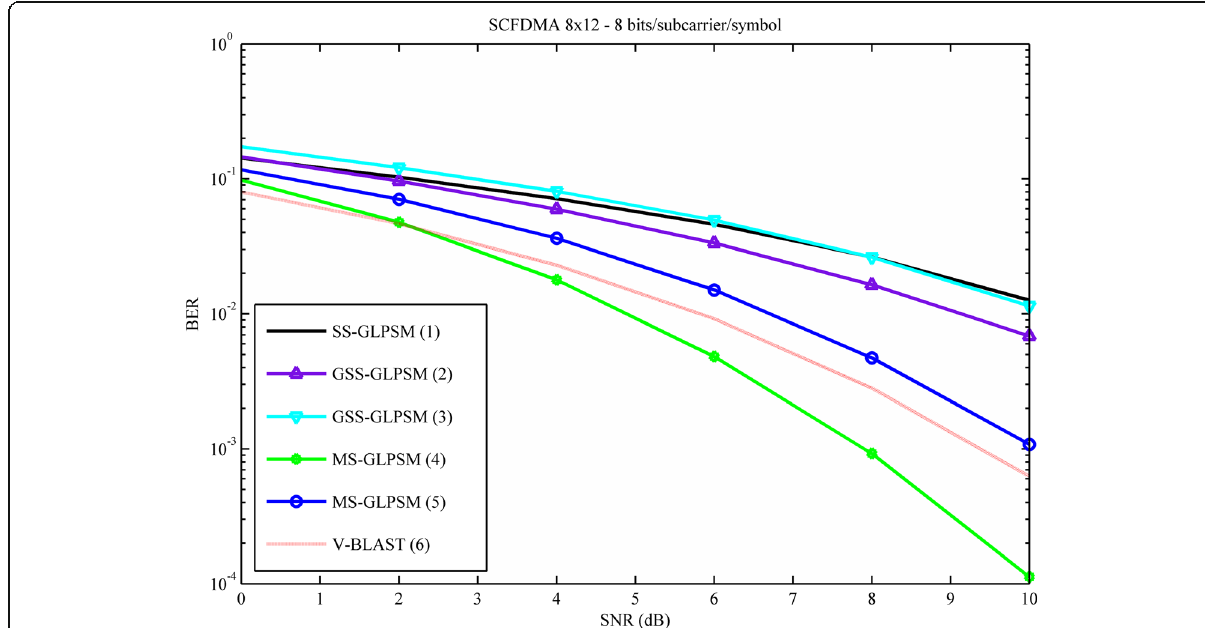
Fig. 4 Performance comparison for SC-FDMA GLPSM and SC-FDMA V-BLAST with the parameters given in Table 1. The performance comparison of the three proposed techniques and SC-FDMA with V-BLAST, given as a reference. The comparison is given with the constraint of the same